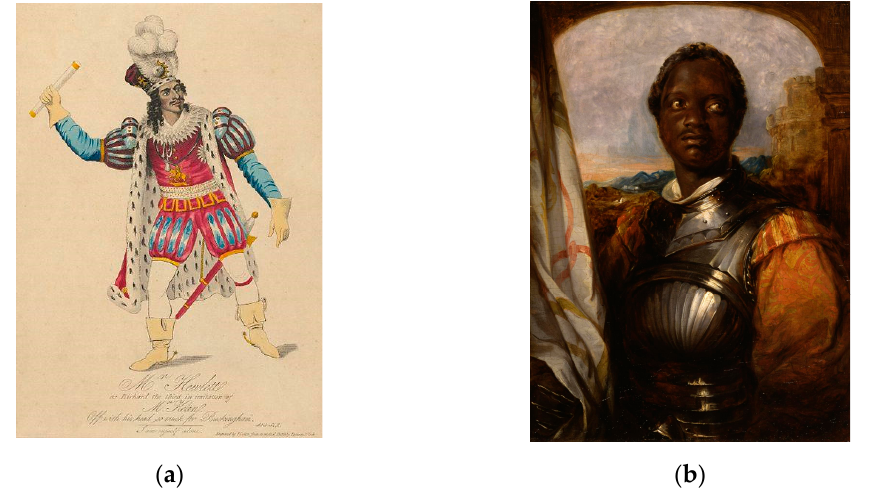
Figure 3. ( a ) James Hewlett as Richard the Third. Engraved by I. Scoles, from a sketch by Parisen. Between 1821 and 1831. Theatrical Portrait Prints (Visual Works) of Men (TCS 44), Harvard Theatre Collection,